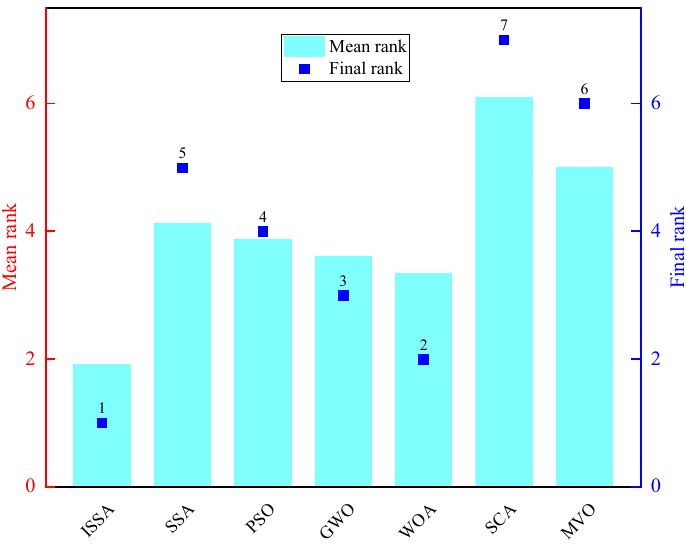
Figure 4. Ranks of all algorithms based on the average values.